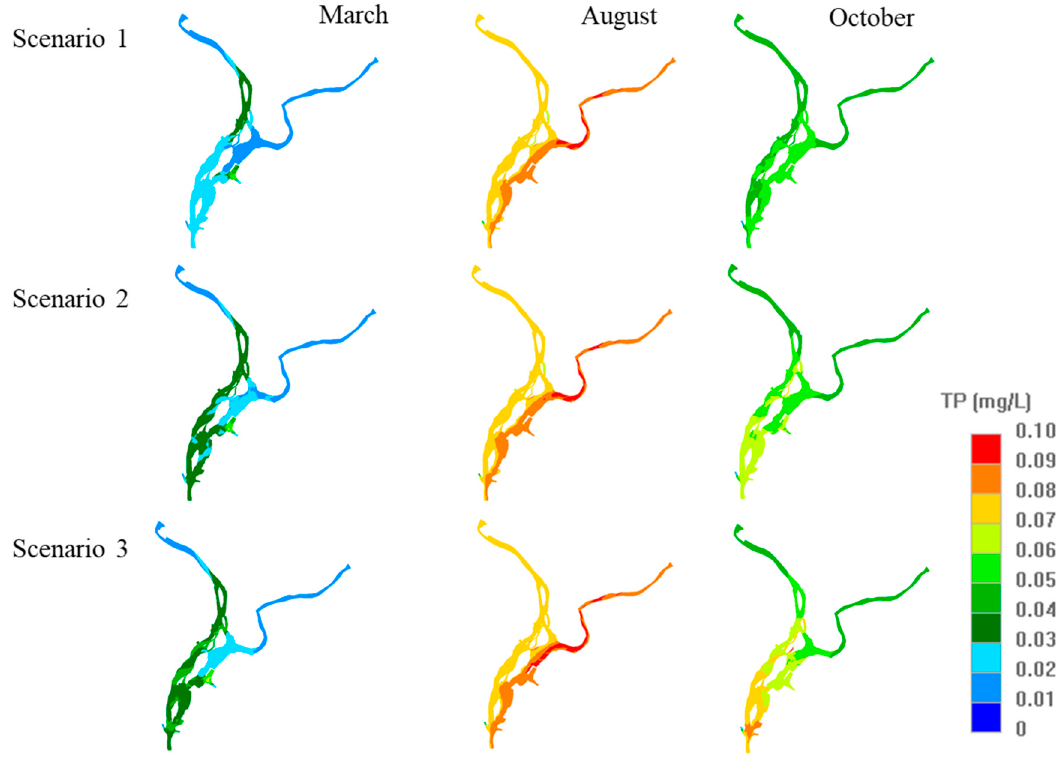
Figure 8. Sensitivity analysis results of seasonal total phosphorus (TP) concentration.